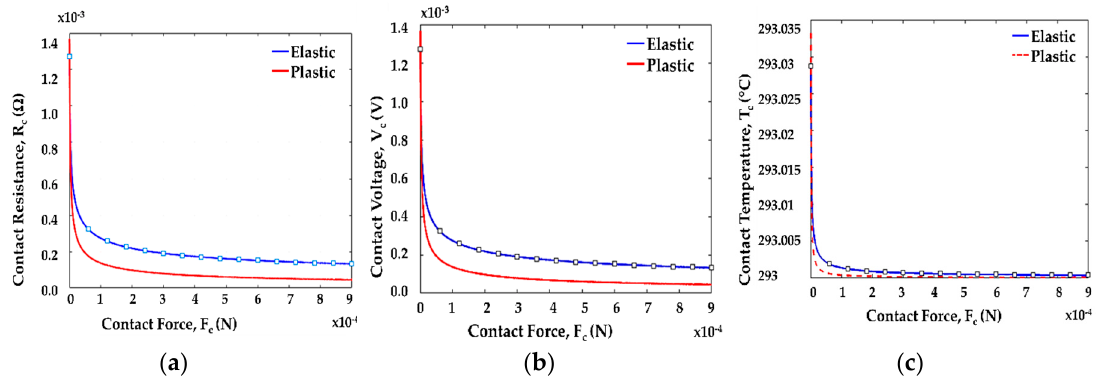
Figure 19. ( a ) Contact resistance; ( b ) contact voltage; ( c ) contact temperature of a single gold (Au) asperity contact for elastic and plastic region.